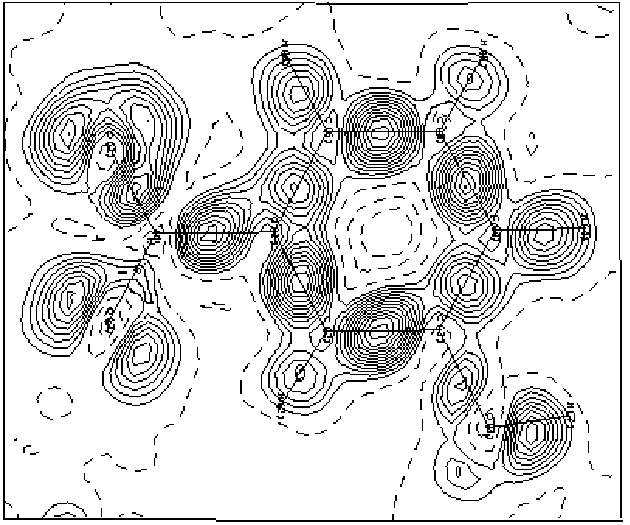
rrr -= , r is the calculated electron density using the Figure 4. Dynamic density map: sphmultdyn mult r is the calculated electron density using the atomic parameters obtained from multipolar model and sph the high-order refinement. Contour map is 0.05 eÅ